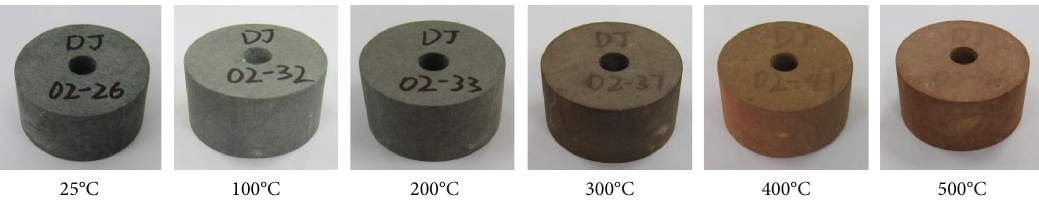
Figure 2: Color change of annular samples with the heating temperature: (a) 25 ° C, (b) 100 ° C, (c) 200 ° C, (d) 300 ° C, (e) 400 ° C, and (f) 500 ° C.